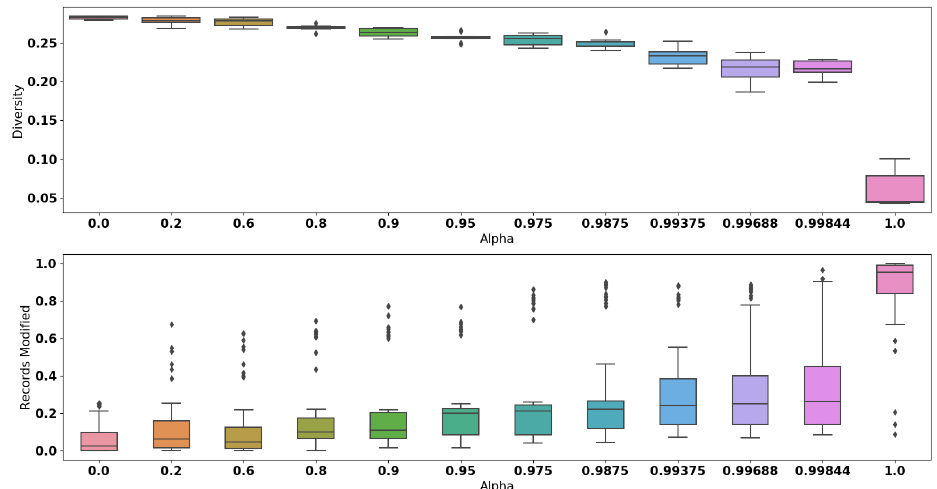
Figure 4. Boxplots of the quantitative analysis of sanitized datasets selected using HeuristicA . These metrics are computed on the whole sanitized dataset. Modified records correspond to the proportion of records with categorical attributes affected by the